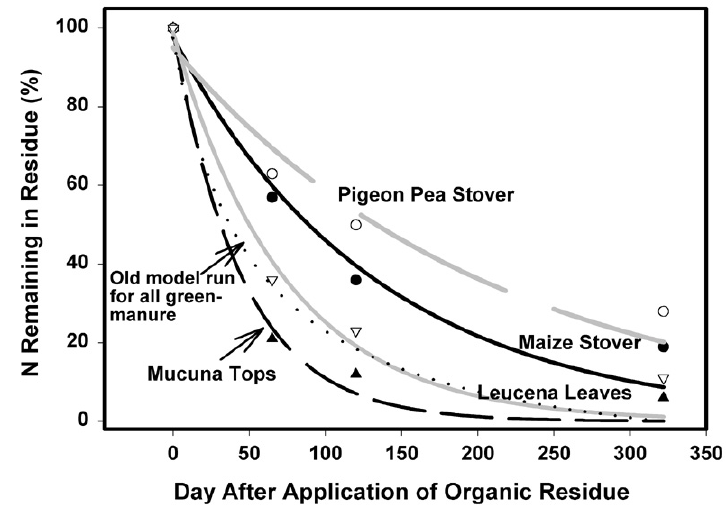
FIGURE 2 . Observed (symbols) and simulated (lines) percentage of N remaining in four different organic residues after field incubation with Zaria soil. Dotted line represents results from the previous version of the model with mucuna, pigeon pea, and